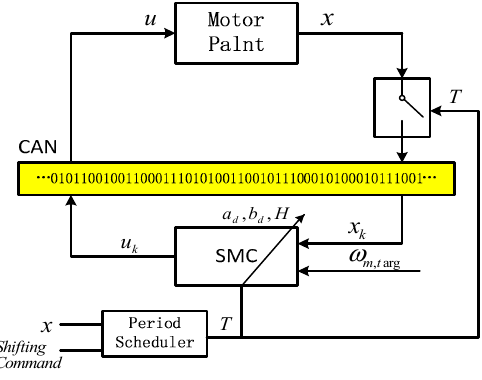
Figure 3. Control diagram of the system. SMC: sliding mode control.